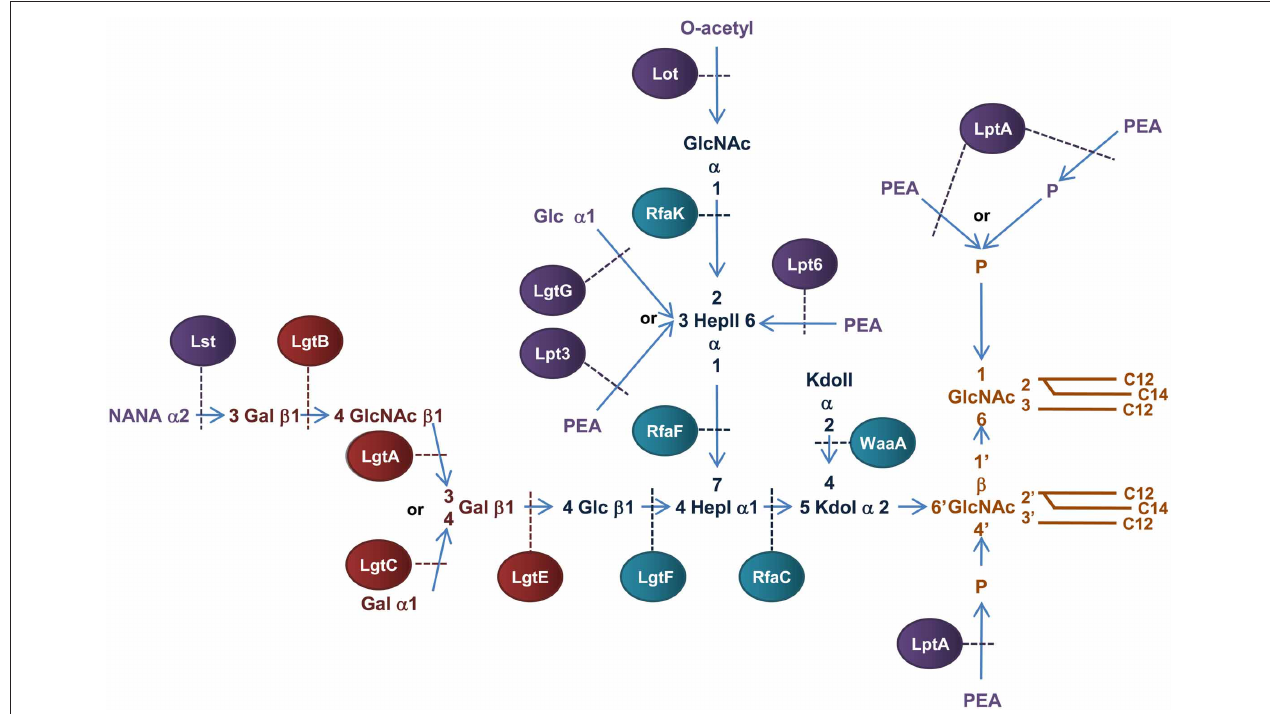
FIGURE 6 | Structure and biosynthesis of N. meningitidis LOS. Conserved Lipid A region is in orange while the conserved inner OS core region is in dark blue and the variable α -chain in maroon. Variable modifications to these regions are in purple. Glycosyltransferases that form the inner OS core backbone and α -chain are denoted by the blue and light